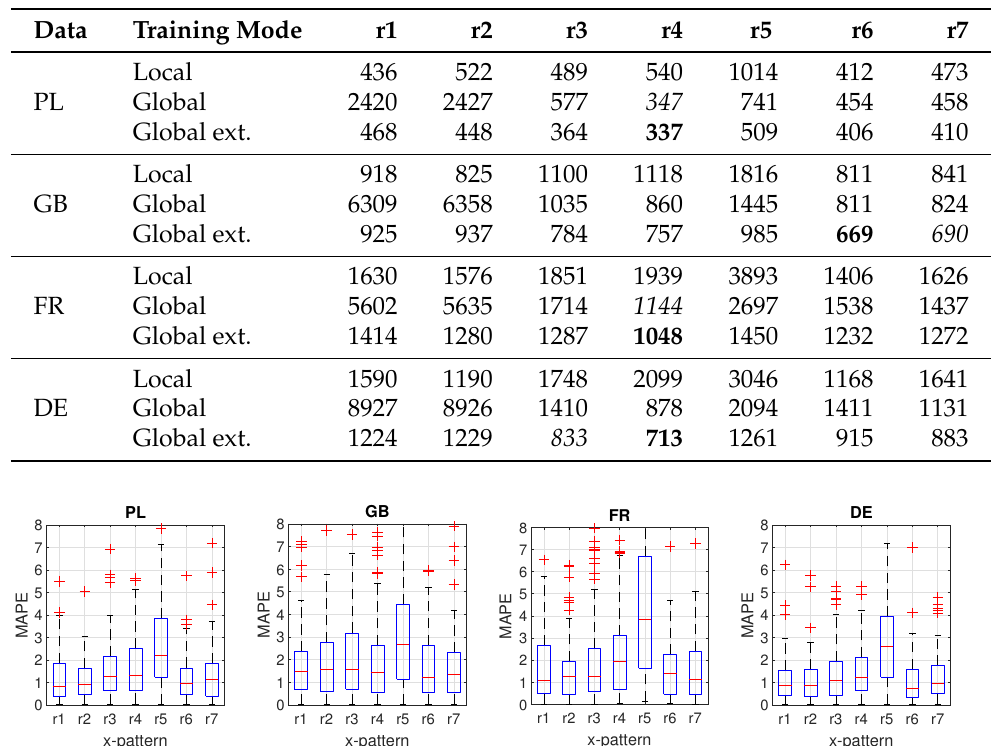
Figure 4. Local training mode: Boxplots of validation MAPE for different input patterns r1–r7.